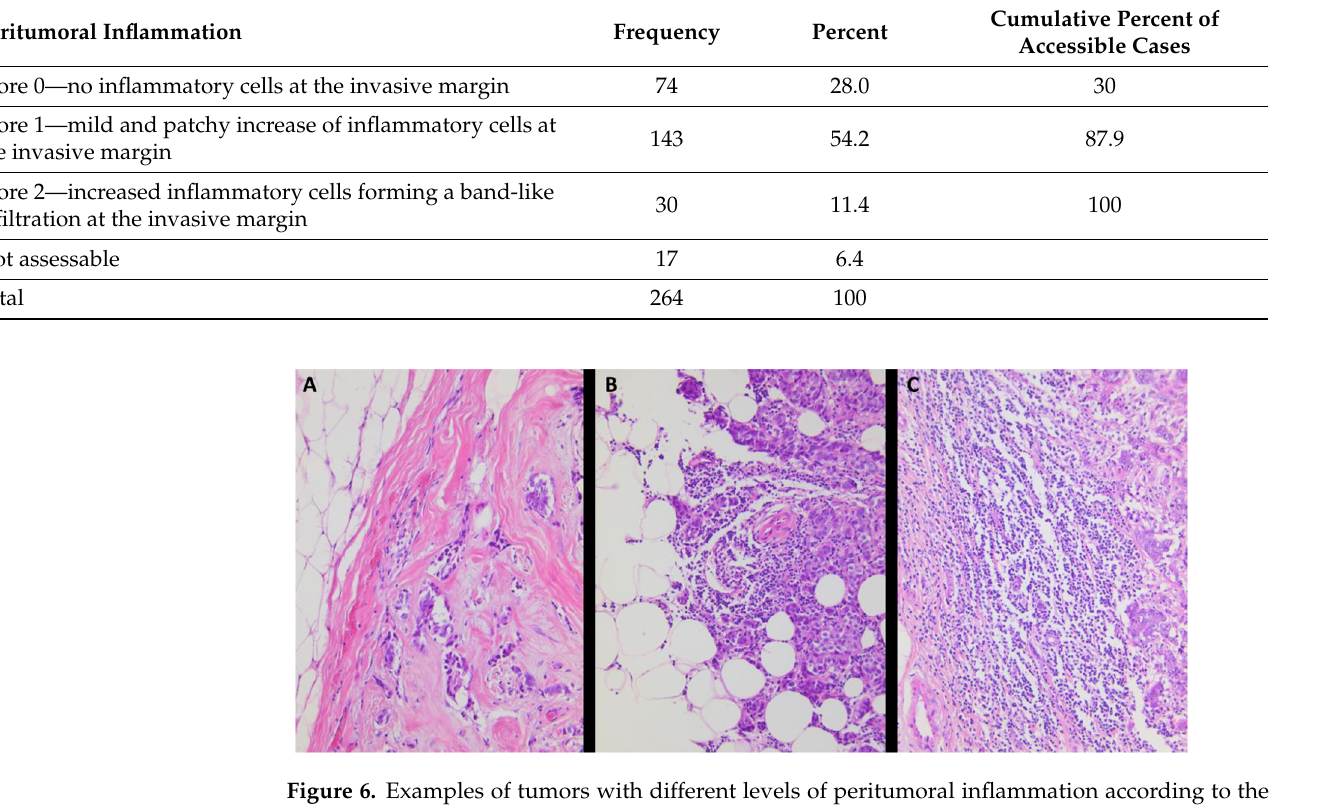
Table 4. Quantification of peritumoral inflammation according to the Klintrup score.